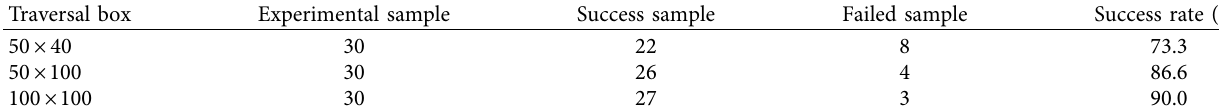
Table 2: The success rate of the three traversal search boxes.